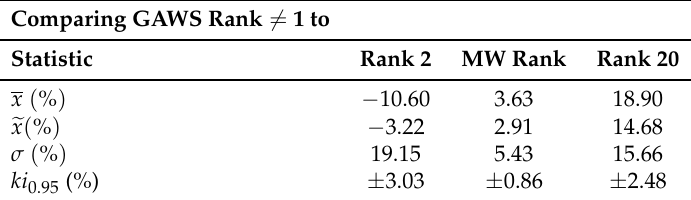
Table 4. Deterioration with GAWS (cid:54) = Rank 1.